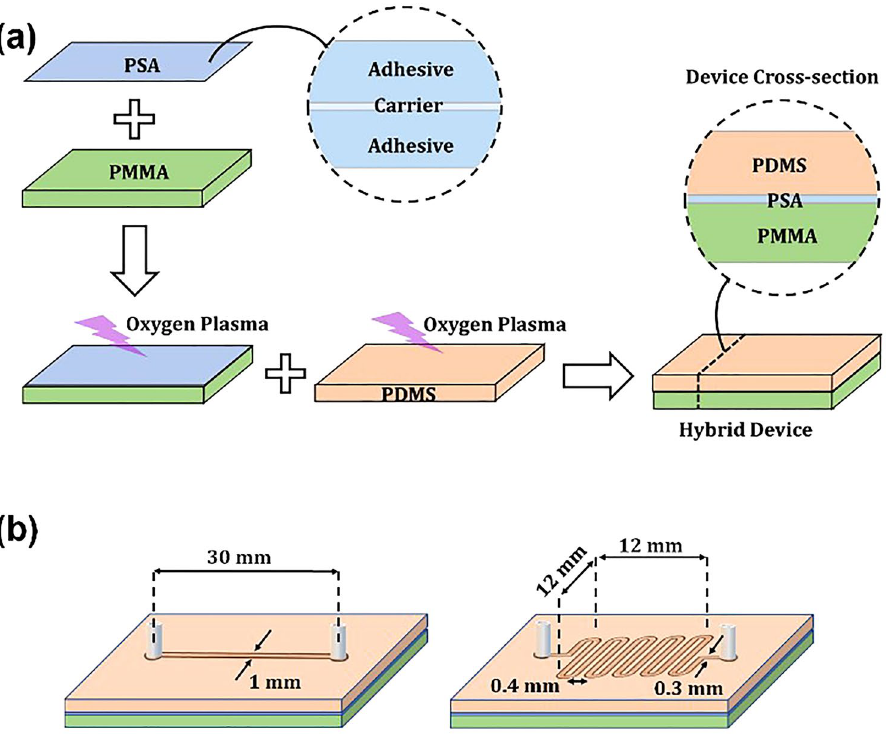
Figure 1. Bonding strategy and microchannel design. ( a ) Schematic of the method to bond PMMA and PDMS layers at room temperature (23 °C). This method was an adhesive-based technique involving oxygen plasma treatment of PDMS bonded to adhesive tape already laminated on PMMA. Double-sided PSA tape is an adhesive strip that is coated on both sides of a flexible plastic film as a carrier. ( b ) Two types of microfluidic chips were fabricated using the adhesive-based technique developed in this work; a simple straight microchannel (total length of 30 mm, height of 0.4 mm, and width of 1 mm) and a serpentine microchannel (total length of 190 mm, height of 0.4 mm, width of 0.3 mm, and gap size of 0.4 mm between the